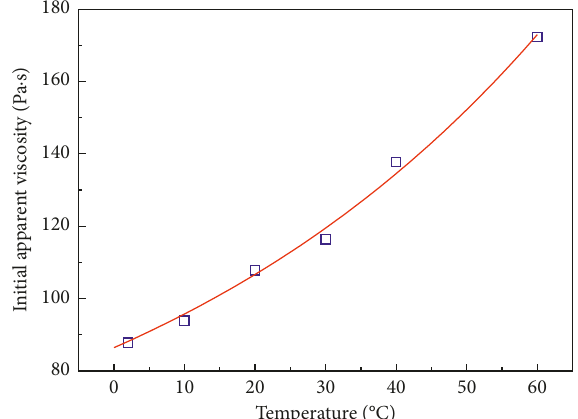
Figure 6: Effect of temperature on initial apparent viscosity (IAV) (the shear time was set at 1